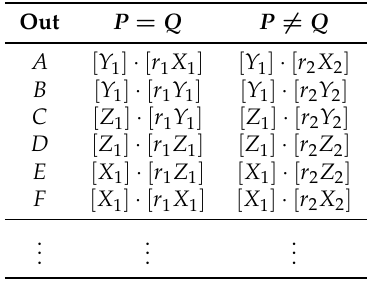
Table A3. Unified point addition for the Hessian elliptic curve